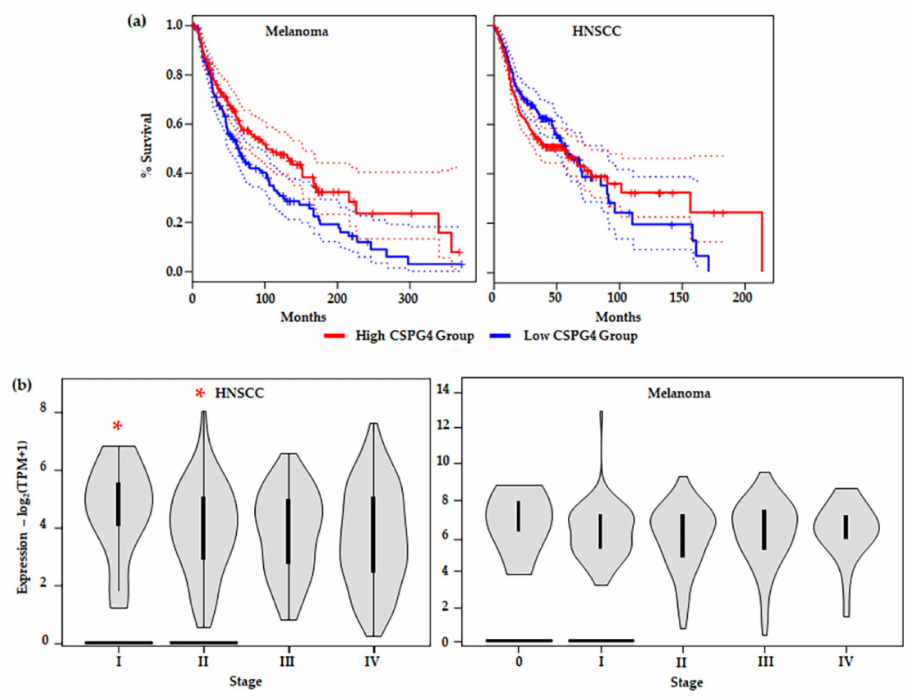
Figure 5. ( a ) Survival analysis comparing tumours with CSPG4 high (top 50%) and CSPG4 low (lower 50%) expressing groups in: ( Left ) melanoma (CSPG4 high , n = 229 & CSPG4 low , n = 229); and ( Right ) HNSCC (CSPG4 high , n = 229 & CSPG4 low , n = 229). Shown, significant overall survival (OS) in CSPG4 high , compared with CSPG4 low s in melanoma {by Kaplan–Meier, α = 005, Logrank p = 0.0082, Hazards ratio/HR (CSPG4 high ) = 0.7, p -value for hazards ratio [ p (HR)] = 0.0086}. Ad- ditionally, shown, no significant OS in CSPG4 high , compared with CSPG4 low in HNSCC [ α = 005, Logrank p = 0.35, HR (CSPG4 high ) = 1.1, p (HR) = 0.35] [47]. ( b ) Stage plots showing CSPG4 expression in different clinical stages, by TNM classification: ( Left ) HNSCC [F value = 3.06, Pr (>F) = 0.0277, by ANOVA ] and ( Right ) melanoma [F value = 0.847, Pr (>F) = 0.496, by ANOVA ]. Note the significant difference in CSPG4 expression between Stage I & II (non-metastatic tumours), compared with Stage III & IV (metastatic tumours) (* p < 0.05, α = 0.05). ( a , b ) derived from analysis of publicly available ACGT Data, accessed through the GEPIA portal